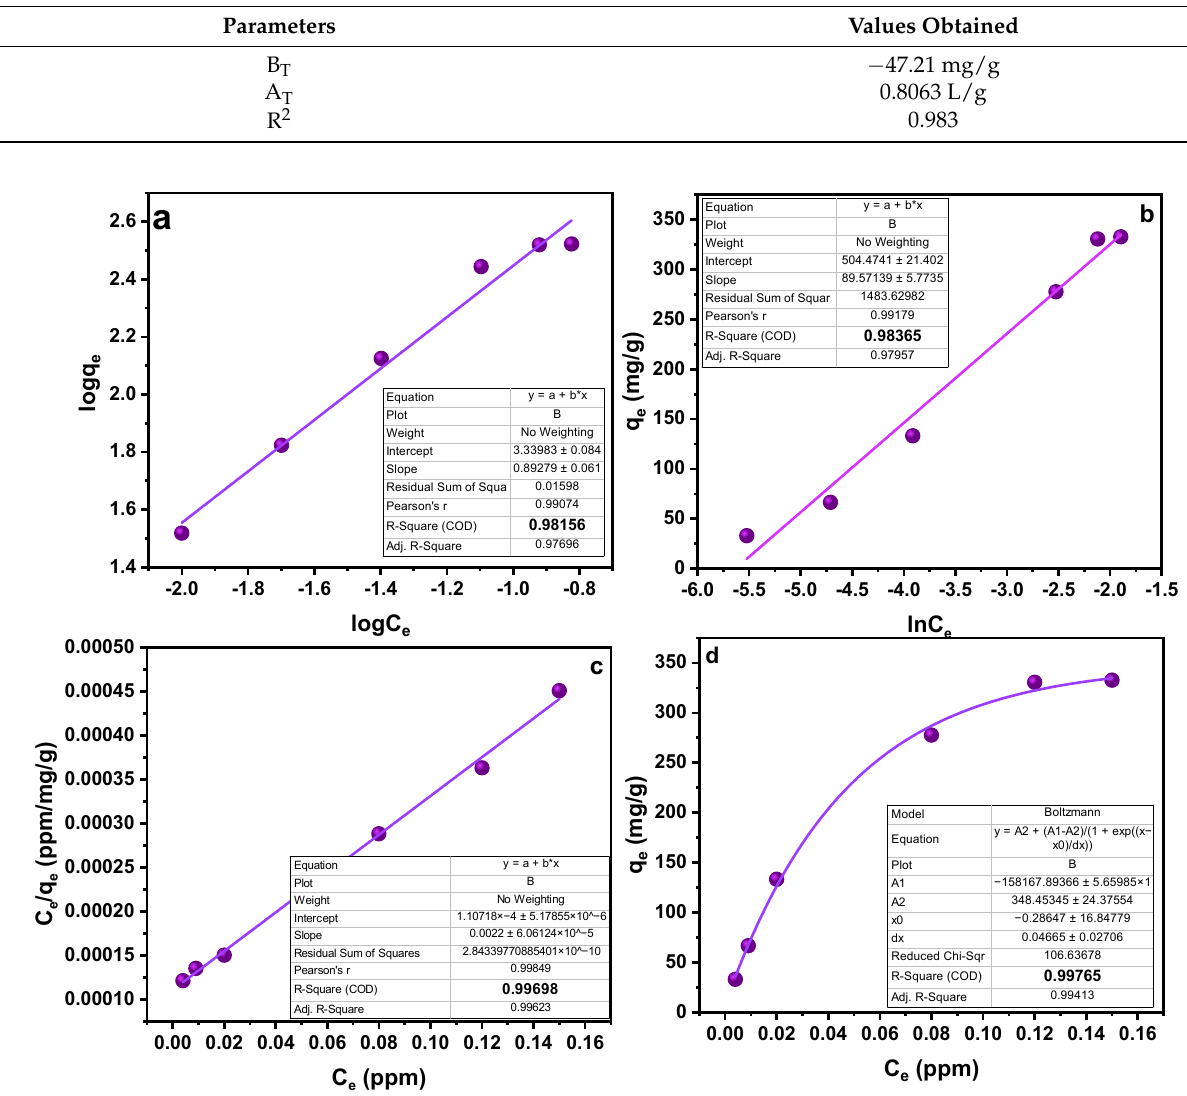
Figure 7. Isotherm studies ( a ) Freundlich Isotherm ( b ) Temkin Isotherm ( c ) Langmuir isotherm (linear) ( d ) Langmuir